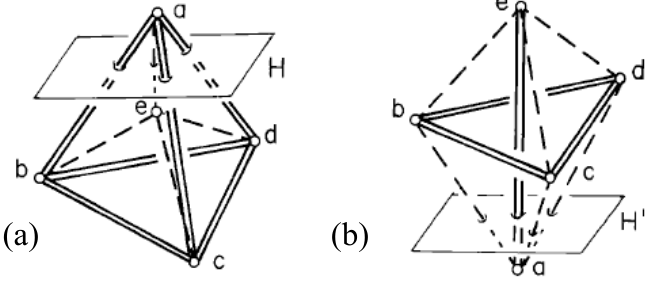
Figure 72. The projection of a 3-dimensional tensegrity framework ( a ) to ( b ) changes the sign of all edges that crossed the plane in ( a ) which is projected to infinity in ( b ).